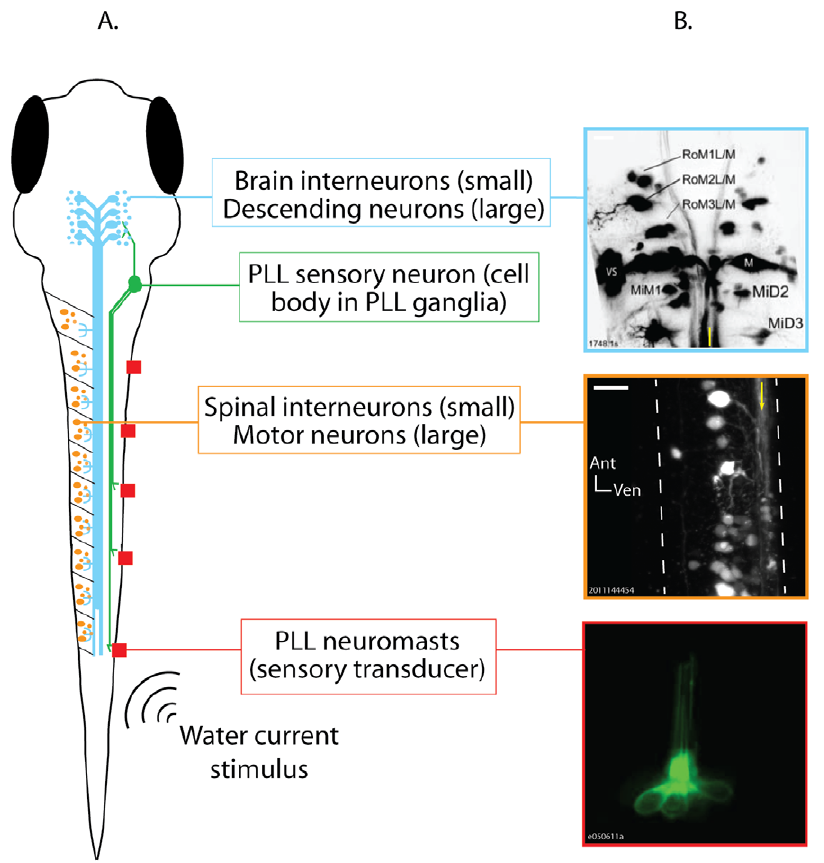
Figure 1. The posterior lateral line (PLL) sensorimotor pathway in zebrafish larvae. A. Schematic representation of a 6 day old zebrafish larva (dorsal view) showing, in different colors, all of the neuron types included in the model pathway, and the effective stimulus for hair cell activation (water current). Neuron types are labeled to the right of the schematic. B. Photomicrographs showing individually identifiable neurons within the PLL sensorimotor pathway. Top: Descending neurons in the hindbrain of a 6 day old zebrafish larva after injection labeling with a fluorescent tracer. The Mauthner neurons (M), Mauthner segmental homologs (Mid2, MiD3), and other identifiable descending neurons can be seen. The image is a maximum projection of 22 optical sections taken at 3 m m intervals through the dorsal-ventral axis of the hindbrain. Anterior is up and the yellow line shows the approximate midline. Middle: Spinal neurons imaged in a 7 day old larva prepared as described for A. The image is a maximum projection of 10 optical sections taken at 2 m m intervals through the rostral spinal cord at approximately the level of the 8 th myotome. The dashed white lines trace the spinal cord’s boundaries, and the yellow arrow is drawn along the bundle of descending axons running down the ventral spinal cord. Bottom: A PLL neuromast. This neuromast was imaged in a single optical section in a 6 day old Brn3c:eGFP transgenic larva, in which all lateral line neuromasts express GFP. Individual hairs (cilia) can be seen extending toward the top of the image. Sensory neurons (not shown) contact the hair cell bodies, which can be seen at the bottom of the image. Scale bars=20 m m.